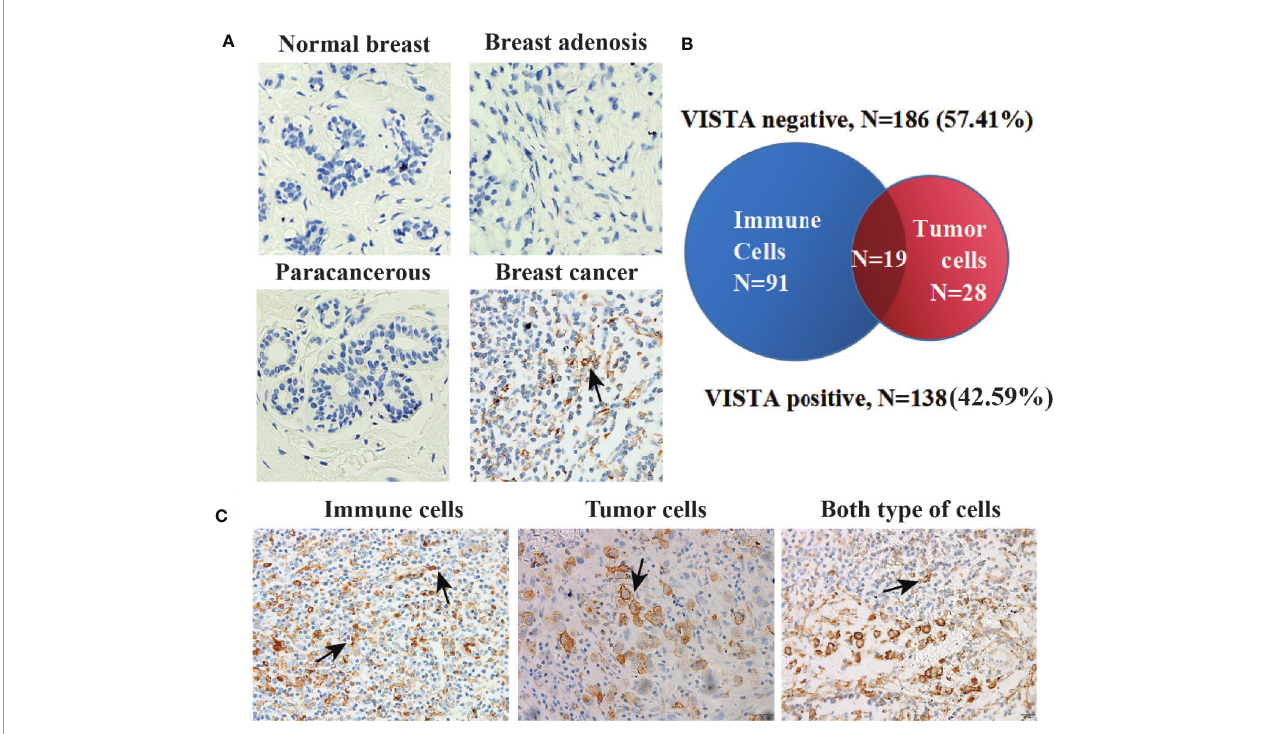
FIGURE 3 | VISTA expression pattern in human breast cancer tissue. (A) Representative immunohistochemical staining for the VISTA protein in normal breast tissue (n=4), breast adenosis tissue (n=2), paracancerous tissue (n=13) and breast cancer tissue (n=324). Original magni fi cation, 400 ×. (B) The expression of VISTA in breast cancer detected by immunohistochemistry. VISTA negative (n=186, 57.41%) vs. VISTA positive (n=138, 42.59%). (C) Representative positive VISTA staining in immune cells (110/324, 33.95%), tumor cells (47/324, 14.51%), and both types of cells (19/324, 5.86%). Original magni fi cation, 200